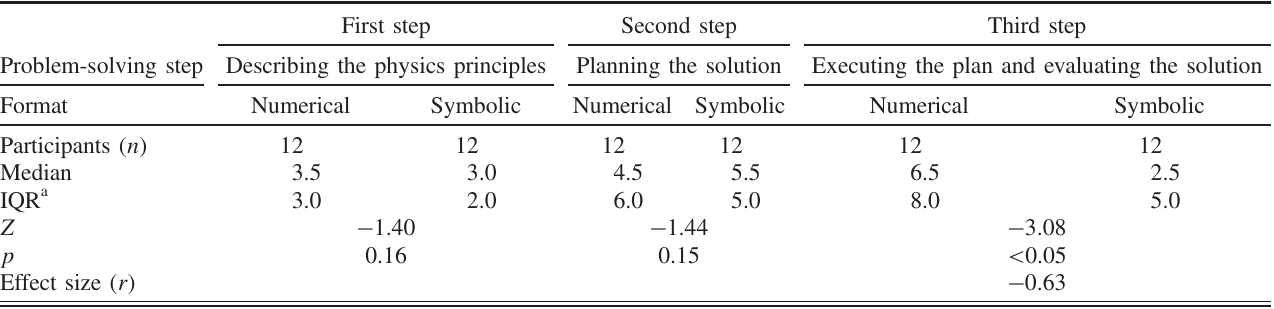
TABLE VI. Differences in the problem-solving performance of students for the numerical and symbolic formats for each problem- solving step.